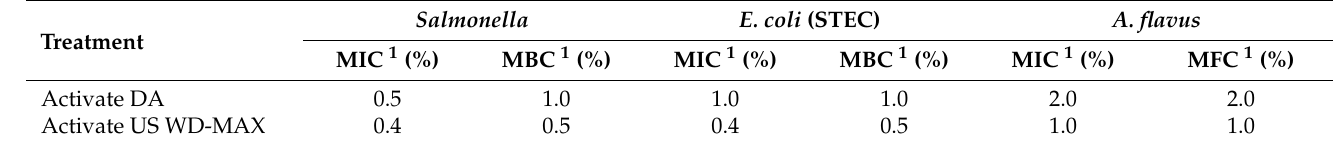
Table 2. Minimum inhibitory concentrations (MICs), minimum bactericidal concentrations (MBCs) and minimum fungicidal concentrations (MFCs) of organic acid mixtures Activate DA and Activate US WD-MAX in nutrient broth (TSB or PDB) against Salmonella, Escherichia coli (STEC) and Aspergillus flavus . A positive control consisted of bacterial or fungal inoculum only (no treatment), and a negative control consisted of tryptic soy broth (TSB) or potato dextrose broth (PDB) only (no treatment, no